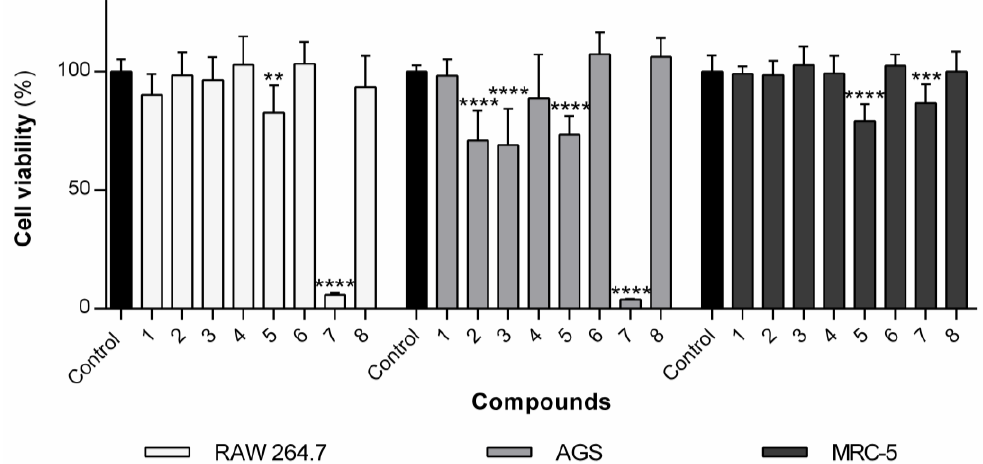
Figure 3. Cell viability of RAW 264.7, AGS and MRC-5 in the presence of compounds 1 – 8 at 100 µM for 24 h. Values are shown with mean ± SD. ** p ≤ 0.01, *** p ≤ 0.001, **** p ≤ 0.0001. The results for compounds 1 and 2 on the viability of RAW 264.7 have been reported previously but are included here for comparison